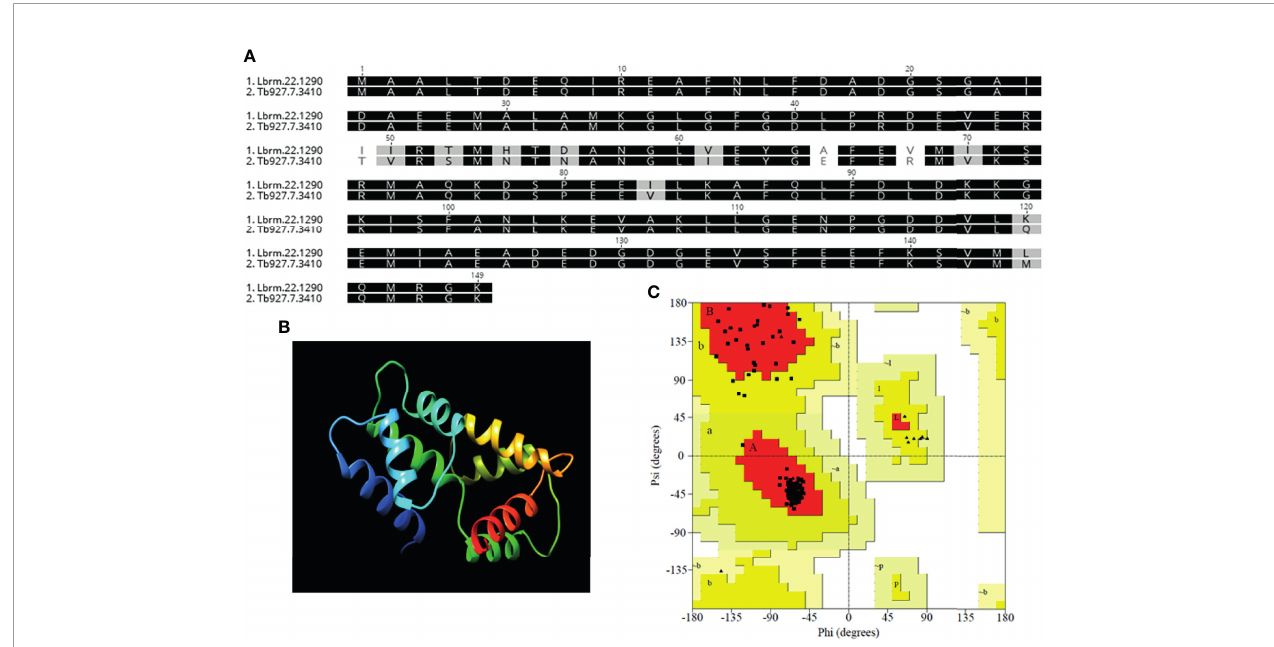
FIGURE 1 | Homology modeling of the derived protein sequence from putative L. braziliensis centrin (LbrM.22.1290). (A) Amino-acid sequence alignment of L. braziliensis (Lbr.M.22.190) and Trypanosoma brucei (Tb927.7.3410) centrin used as the template for the structure prediction with 99.9% con fi dence and 100% sequence coverage. (B) Three-dimensional structure of the predicted protein and (C) Ramachandran analysis of the predicted L. braziliensis centrin: Red: most favored regions, Yellow: additional allowed, generously allowed regions and Light Yellow- disallowed